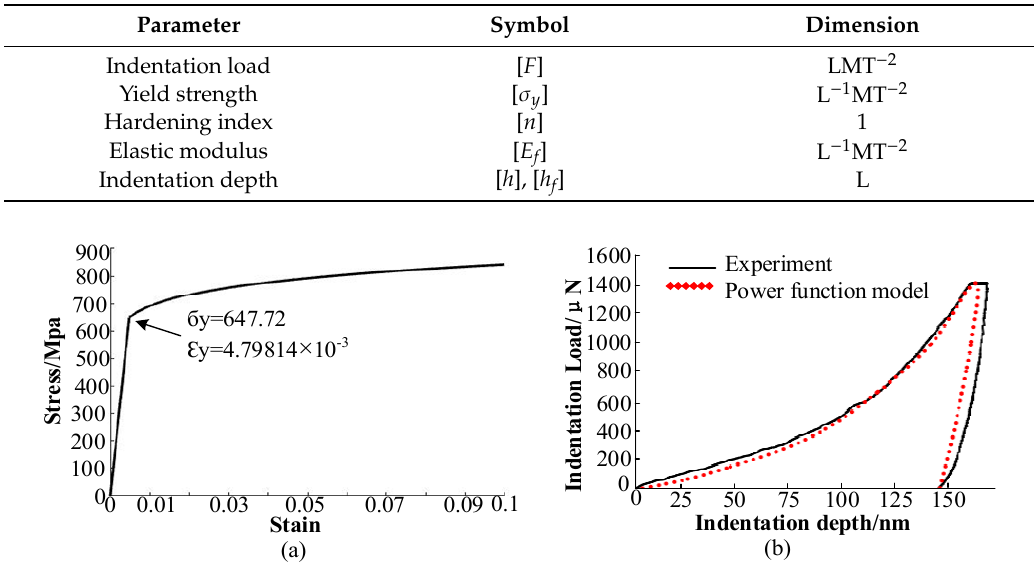
Figure 5. Mechanical behavior of zinc coating: ( a ) Stress-strain curve, ( b ) Comparison of the results of the indentation curve between numerical simulation and test.